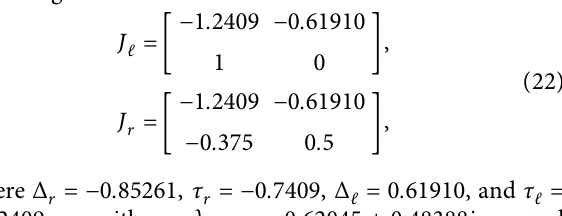
Figure 2: (a) Bifurcation diagram at varying the parameter k . (b) Basin of attraction of the period 5-cycle at k � 0 . 5 ,c � 0 . 3 , δ � 0 . 5525470489 , β � 0 . 11 and k � 5 . 78. (d) Phase plane for the chaotic attractor at ω � chaotic attractor at ω � 0 . 5 , c 1 2 � 0 . 5 , c � 0 . 3 , δ � 0 . 5525470489 , β � 0 . 11 and k � 5 . 0 . 5 ,c 1 2